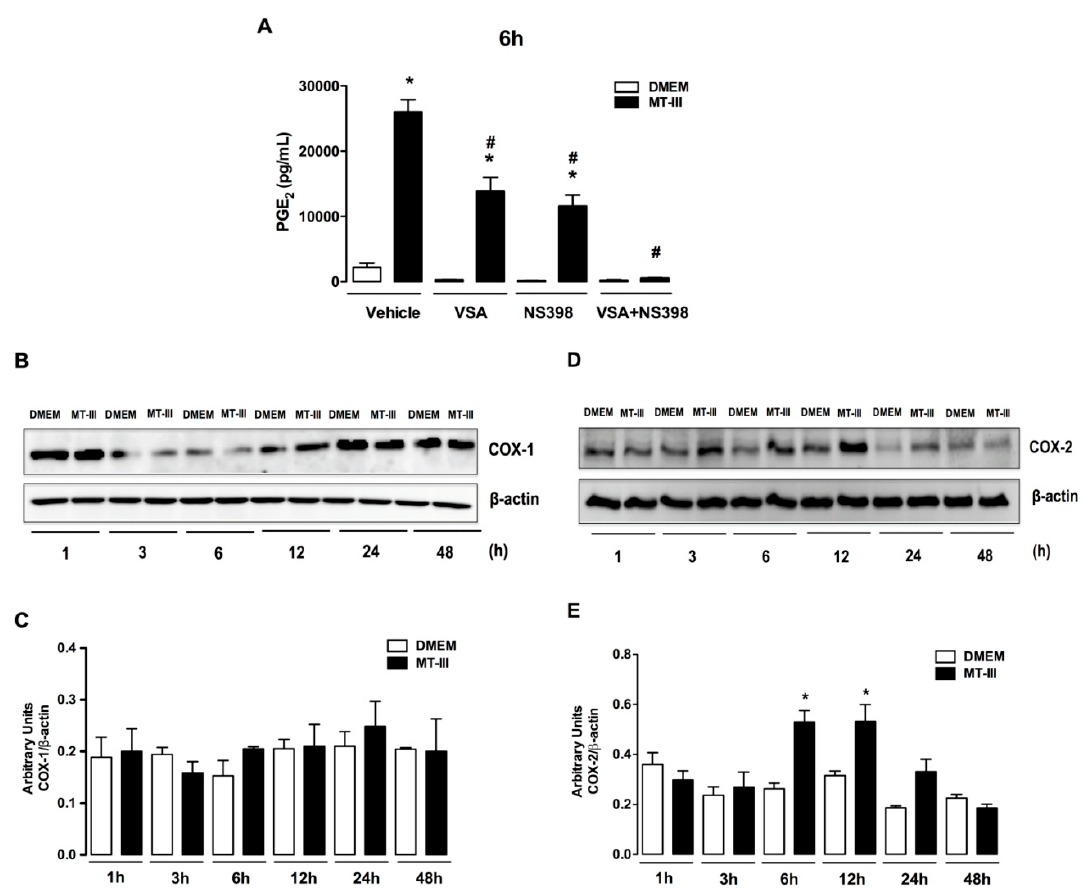
Figure 2. MT-III activates COX-1 and COX-2 pathways for release of PGE 2 by 3T3-L1 preadipocytes. ( A ) Cells were incubated with either valerylsalicylate (VSA) (10 µ M), or NS-398 (10 µ M), or both for 1 h, followed by incubation with MT-III (0.4 µ M) for 6 h. PGE 2 concentrations were quantified in culture supernatants by EIA commercial kit. ( B – E ) 3T3-L1 preadipocytes were incubated with MT-III (0.4 µ M) or DMEM (control) for 1 up to 48 h. ( B ) Western blotting of COX-1 and β -actin (loading control) showing immunoreactive bands. ( D ) Western blotting of COX-2 and β -actin (loading control) showing immunoreactive bands. Densitometric analysis of immunoreactive ( C ) COX-1 and ( E ) COX-2 bands. Density data (in arbitrary units) were normalized with those of β -actin. Results are expressed as mean ± SEM from 3 independent experiments. * p < 0.05 as compared with control group and # p < 0.05 as compared with MT-III group (two-way ANOVA and Bonferroni posttest).